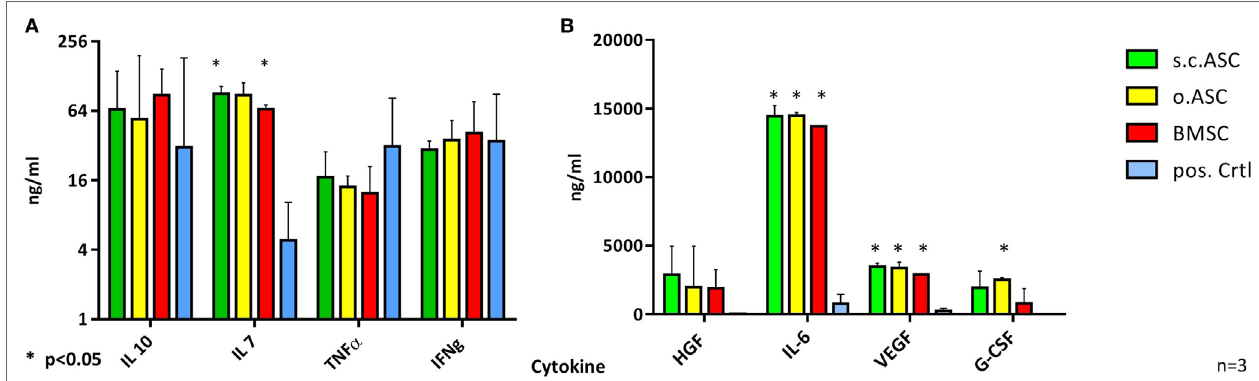
FigUre 6 | Multiplex analysis of mixed lymphocyte reaction (MLR) supernatants ( n = 4 from four biological replicates) using allogenic human mesenchymal stem cells (MSCs) (ratio 4:1) on day 5. While there was no significant difference in levels of IL-10, TNF α , or IFN γ (a) between MLR with added MSC compared with phytohemagglutinin stimulated peripheral blood mononuclear cells alone, statistical analysis revealed a significant increase in levels of IL-6 and VEGF (B) for all three tested MSC. s.c.ASC and bone marrow-derived mesenchymal stem cell (BMSC) demonstrated a significant increase of IL-7 while o.ASC increased levels of G-CSF